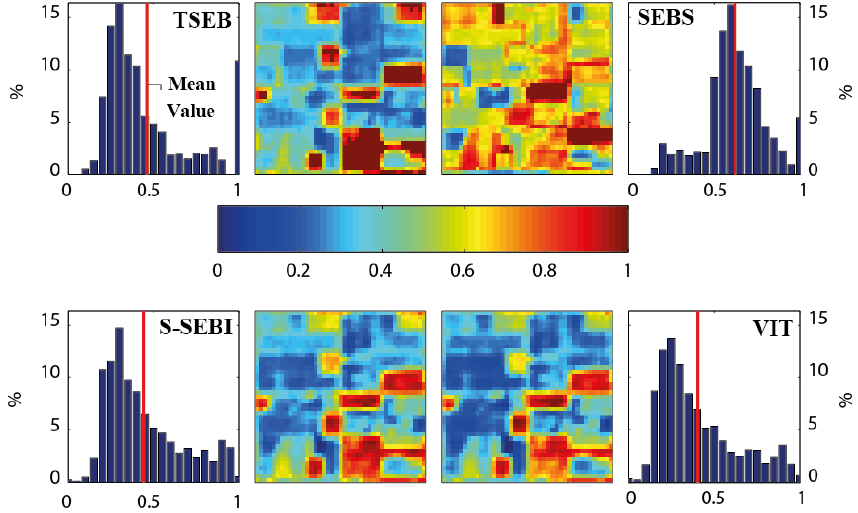
Fig. 12. Stress frequency histograms and maps for the whole area on 6 May.